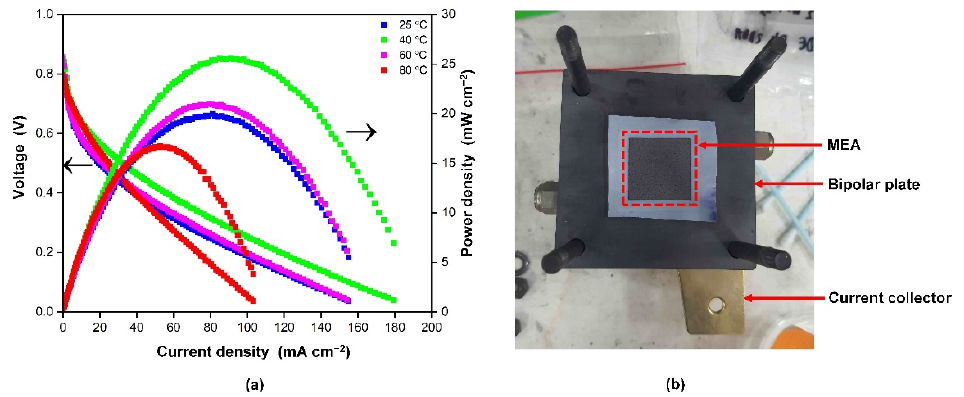
Figure 8. ( a ) Single-cell performance of phosphorylated NdC with different temperatures, ( b ) MEA assembly in PEMFC single-cell set-up. assembly in PEMFC single-cell